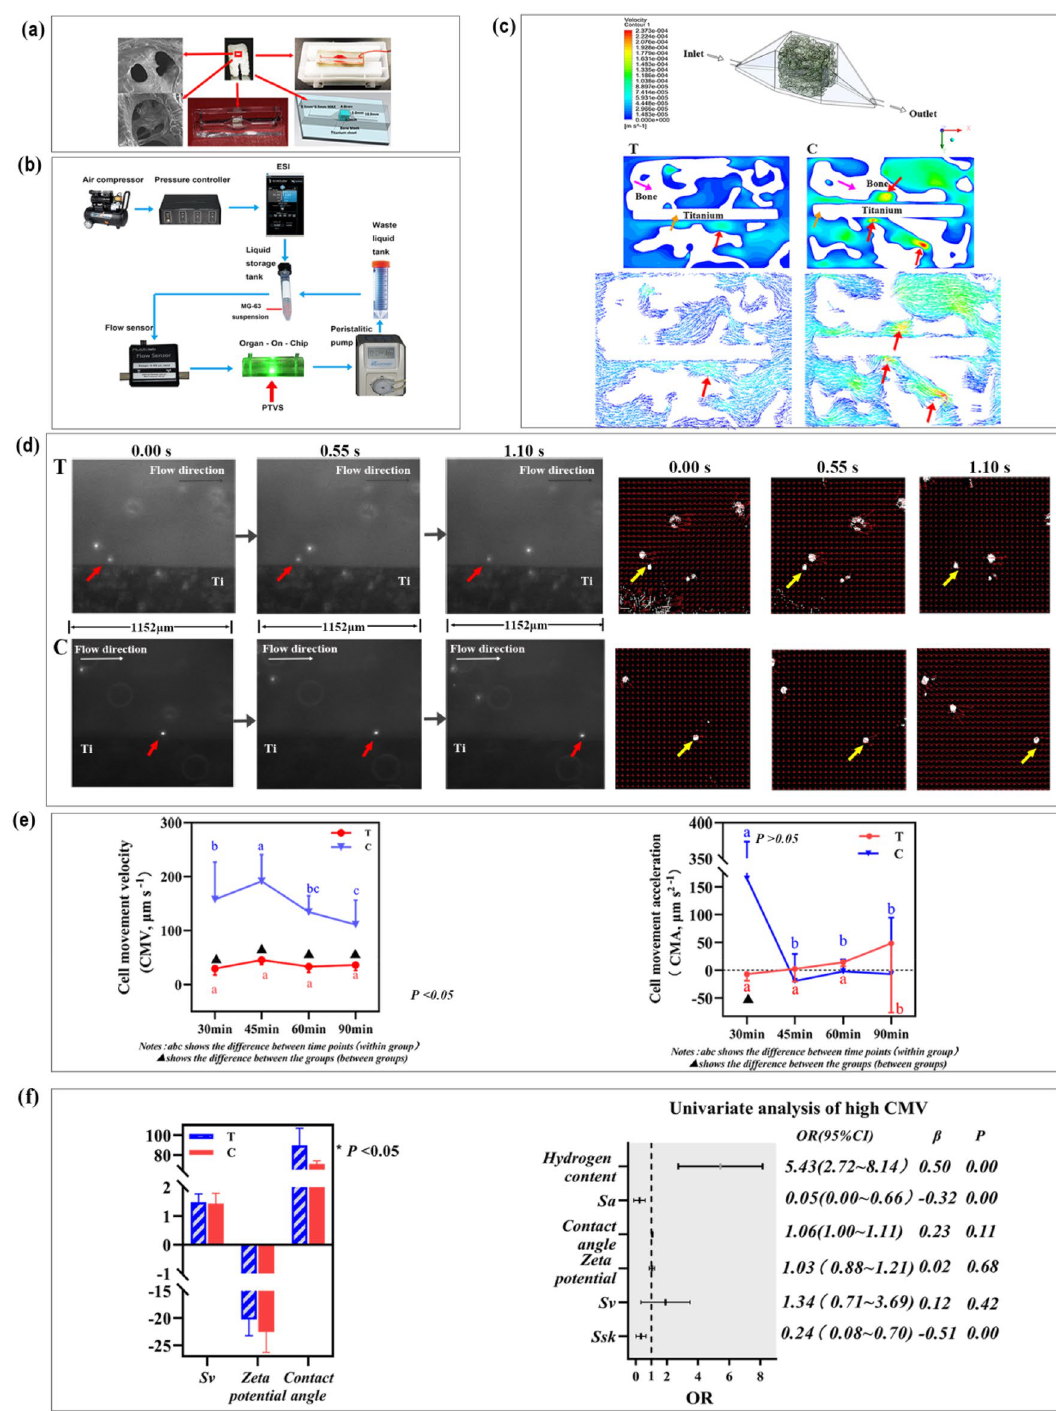
Figure 3. The variation of implant surface morphology affected the cell movement velocity (CMV). ( a ) Design of the tissue-on-chip (TOC). ( b ) The instrument connections of the microfluidic pressure and flow control system. ( c ) 3D reconstruction of the TOC; the velocity contour of the TOC-T and TOC-C, generated using Fluent 19.0. The red arrows indicate that CMV increases when the fluid passes through the smaller cross- sectional area of the bone cavity. ( d ) Live images and velocity vector diagrams of MG-63 cells traversing the TOC-T and TOC-C. ( e ) The CMV of group T was significantly lower than that of group C ( P < 0.05); there was no significant difference in the CMA of groups T and C ( P > 0.05). ( f ) The values of Sv, contact angle, and zeta potential of groups T and C; Factors contributing to high CMV: Sa and Ssk negatively influenced the high CMV of MG-63, accounting for − 32% and − 51%, respectively ( P < 0.05). Sv , contact angle, and zeta potential did not affect CMV ( P > 0.05); the hydrogen content was an indirectly positive factor for high CMV ( P < 0.05). The statistical significance was set at P < 0.05. This figure was generated by Adobe photoshop CC